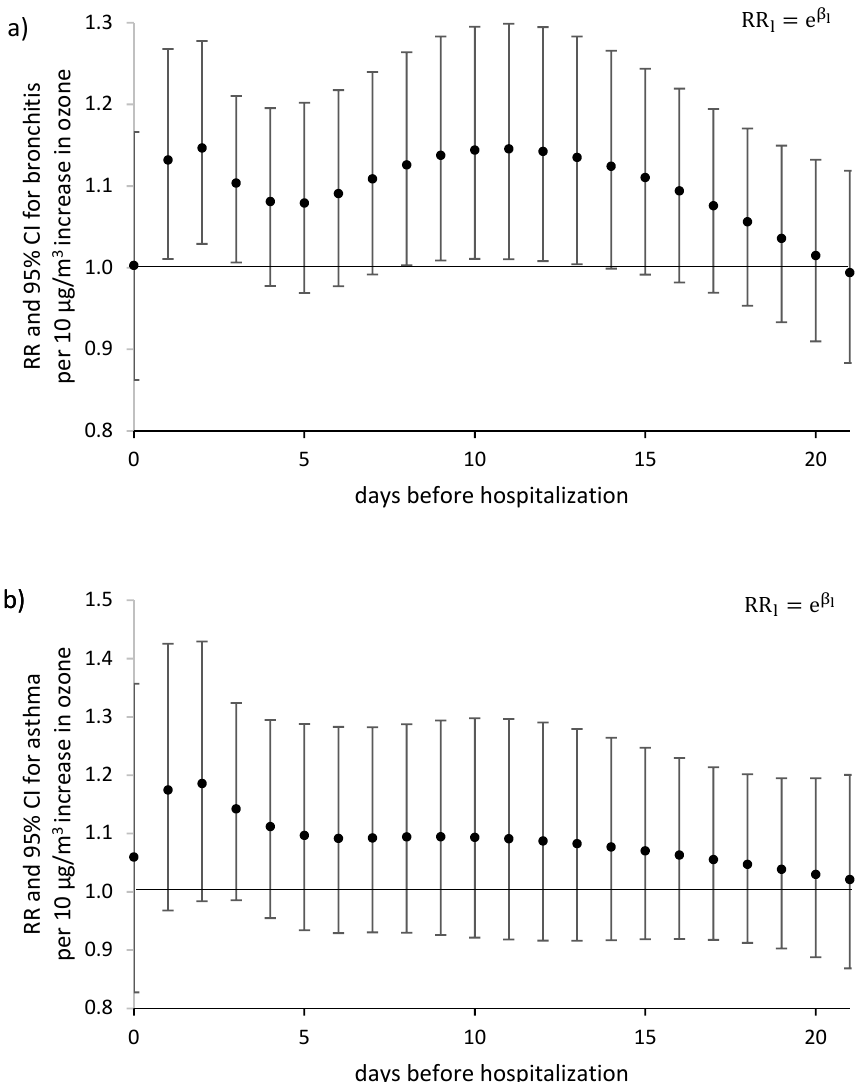
Figure 4. Relative risk RR l of daily hospitalizations due to: ( a ) Bronchitis (J20–J21), ( b ) asthma (J45–J46), associated with an 8 h ozone concentration increase by unit (10 µ g / m 3 ) compared to a normative value of 120 µ g / m 3 . The day 0—the day of registered hospitalization; the day l —the day before hospitalization.